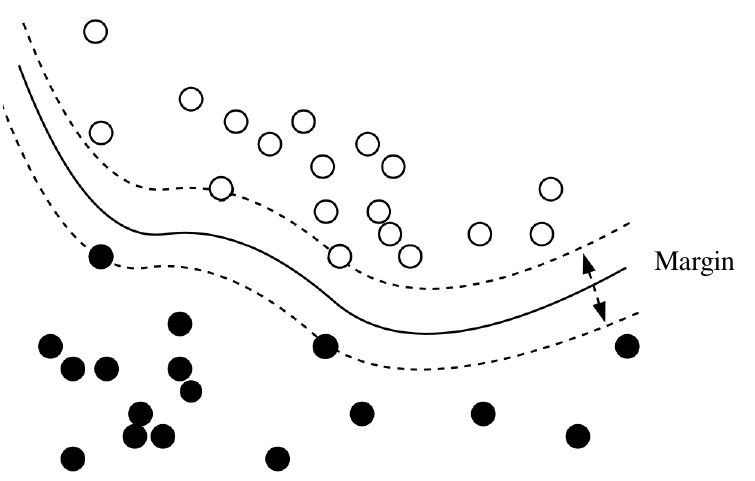
Figure 9. Support vector